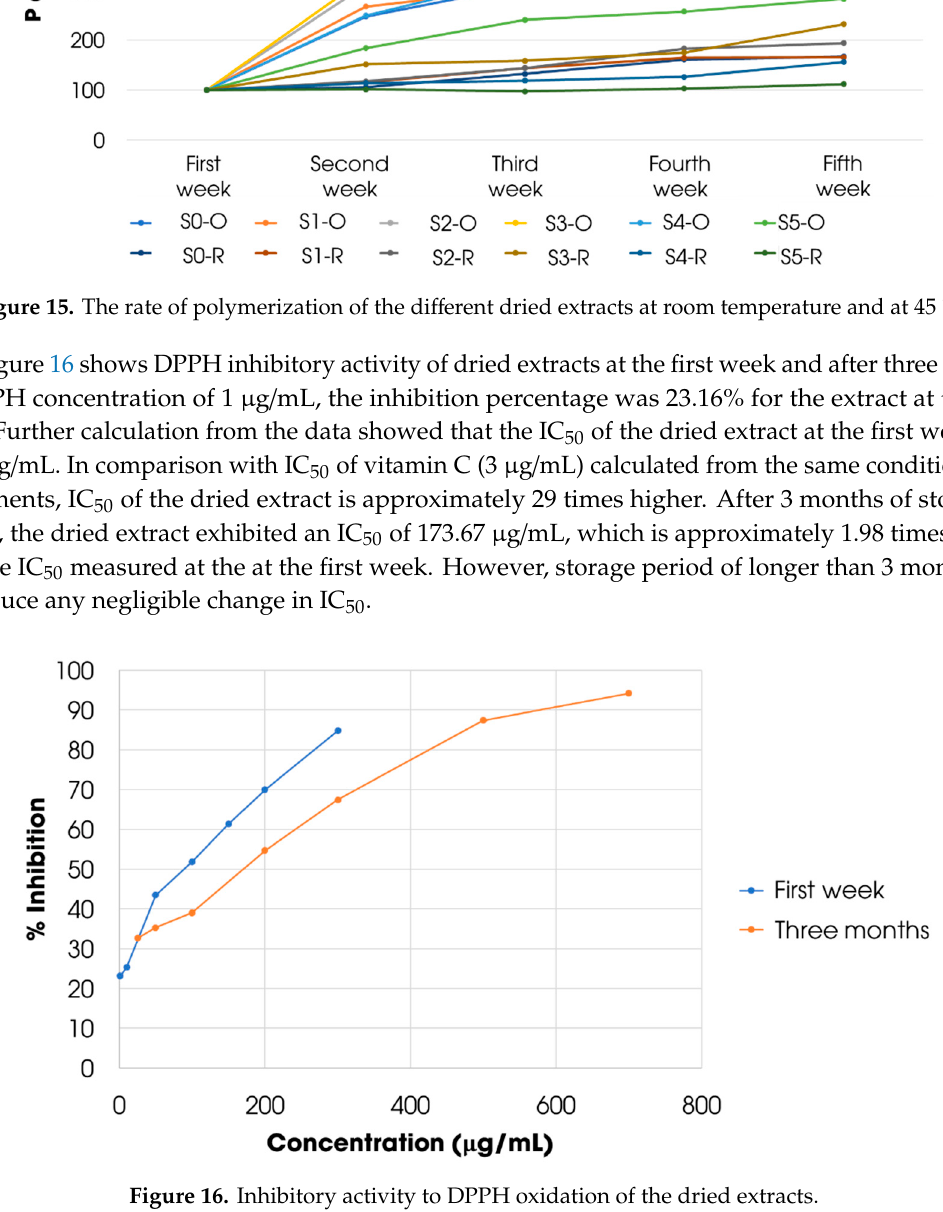
Figure 16. Inhibitory activity to DPPH oxidation of the dried extracts.